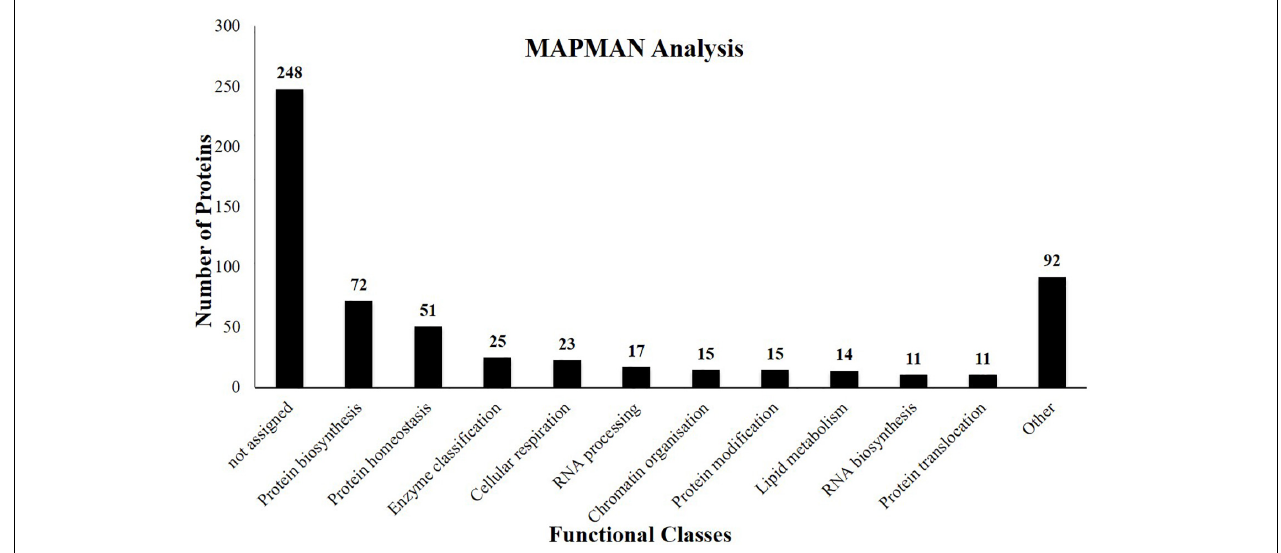
FIGURE 2 | Functional classes of the proteins identified from the embryo of J. curcas seeds based on the bincodes of MapMan. TABLE 1 | Proteins related to lipid metabolism identified from the embryo of mature Jatropha curcas seeds. Protein accession Description Best hit Ricinus Best hit